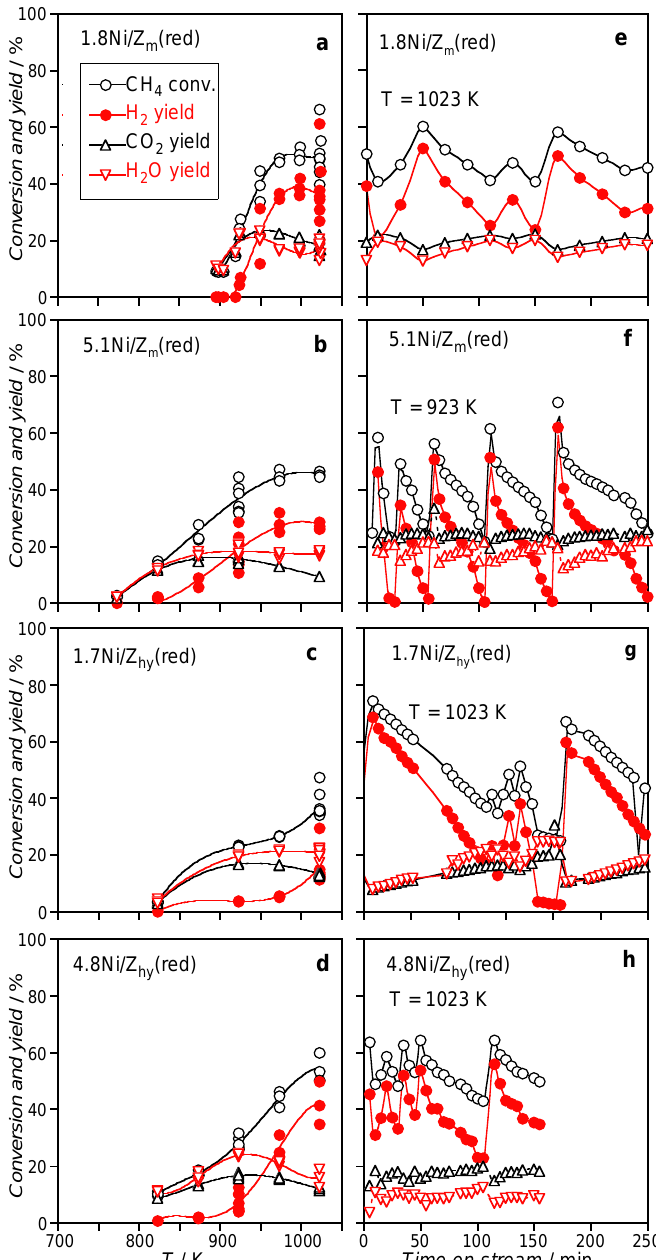
Figure 13. Catalytic activity (CH 4 conversion and H 2 , CO 2 and H 2 O yields) of Ni/ZrO 2 catalysts after red activation treatment in experiments as a function of temperature (left side: a – d ) or as a function of time on stream at set temperatures (right side: e – h ). Reactant mixture: [CH 4 ] = 2%, [O 2 ] = 1%, N 2 as balance; total flow rate = 150 cm 3 (STP)·min −1 .